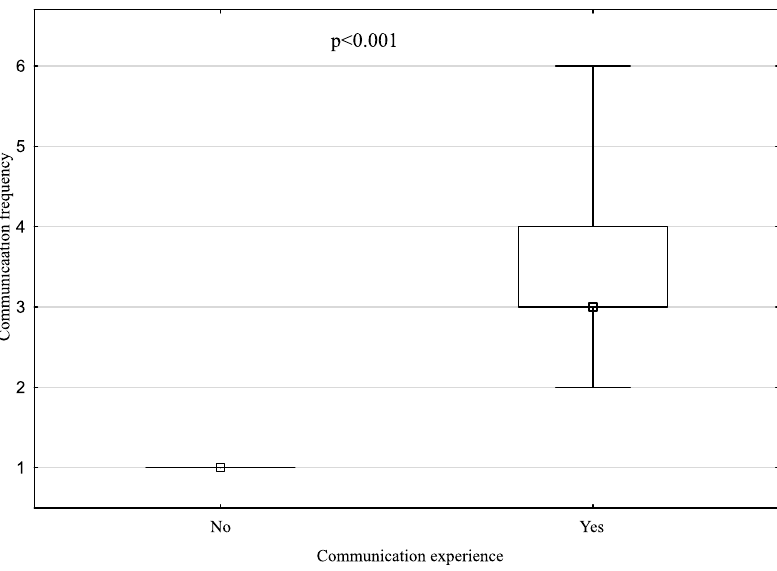
Figure 2. Frequency of communication according to the declared experience of communication with an elderly person in suicidal